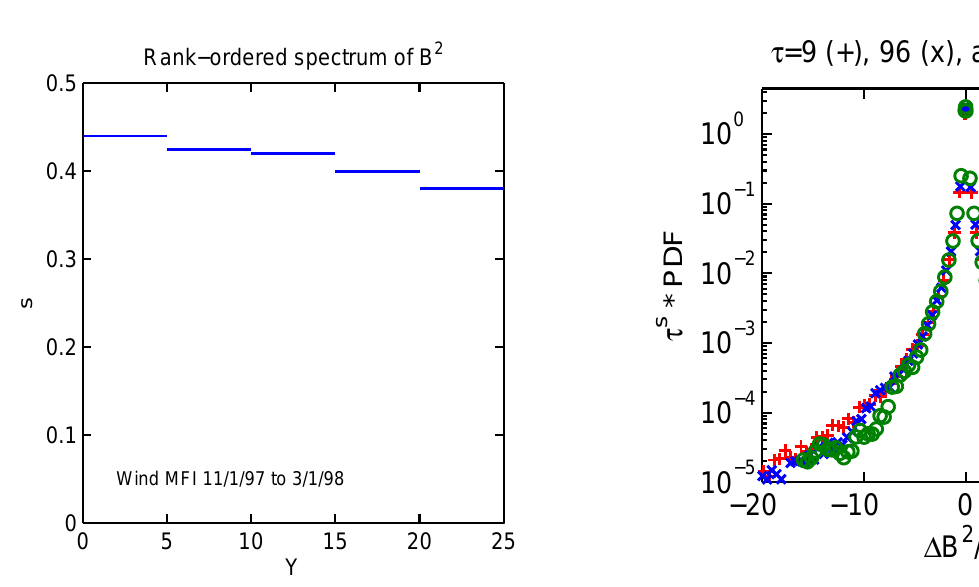
Fig. 3. Rank-ordered multifractal spectrum for a particular set of solar wind data from WIND for fluctuations between 3 and 1500s. The spectrum is calculated for 5 contiguous ranges of 1Y .